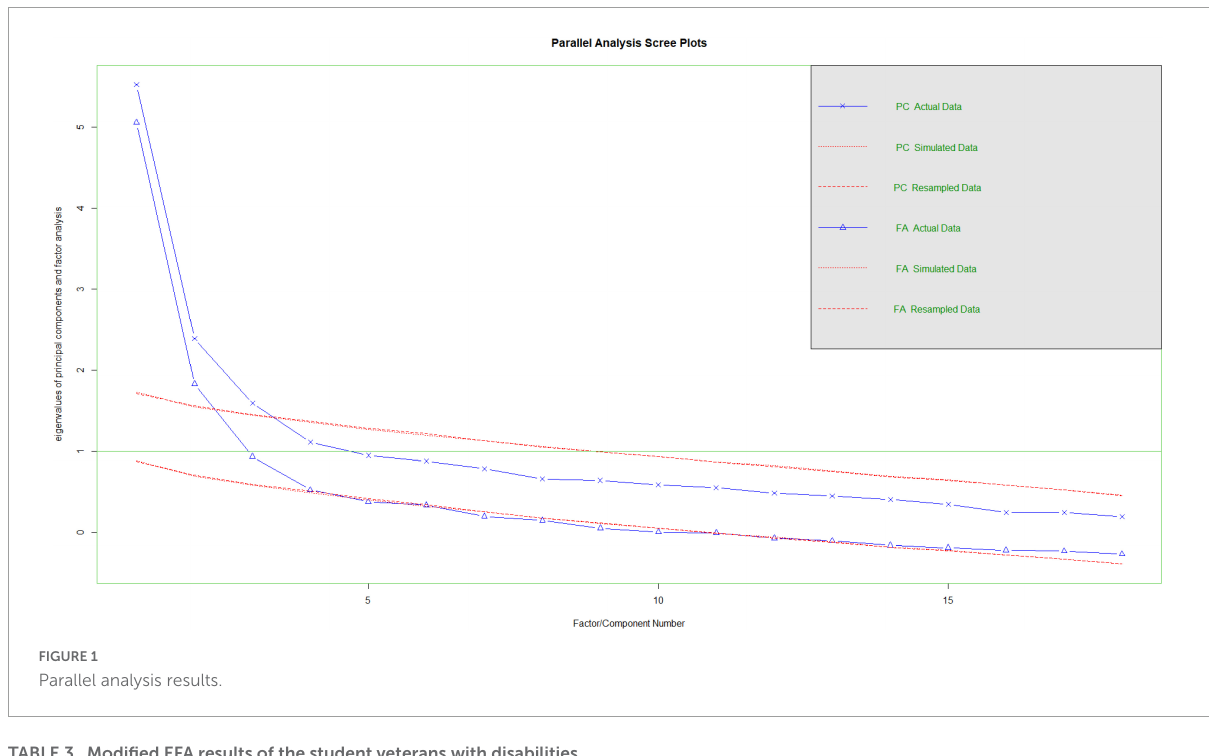
TABLE 3 Modified EFA results of the student veterans with